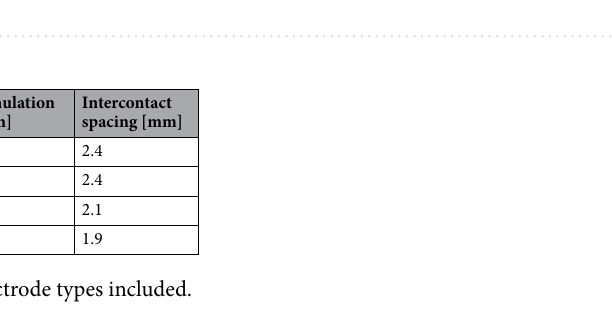
Table 1. Demographic details of the subjects. Subjects are numbered according to the order in which they participated in the study.